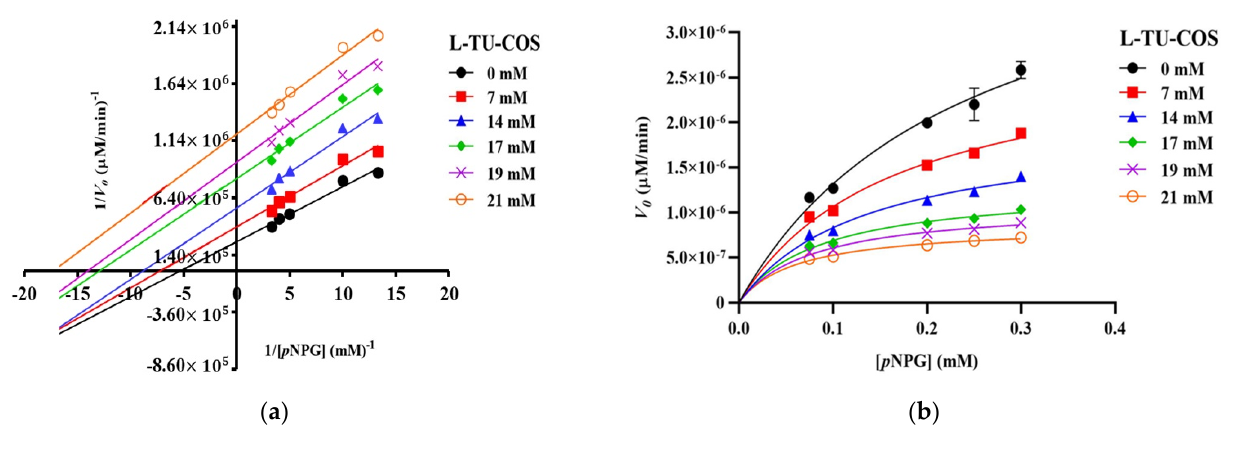
Figure 4. Kinetic analysis of α -glucosidase inhibition. ( a ) Lineweaver–Burk plot and ( b ) Michaelis– Menten plot of the inhibition kinetic by L-TU-COS with different concentrations of p NPG. The values are given as mean ± SD ( n = 3).